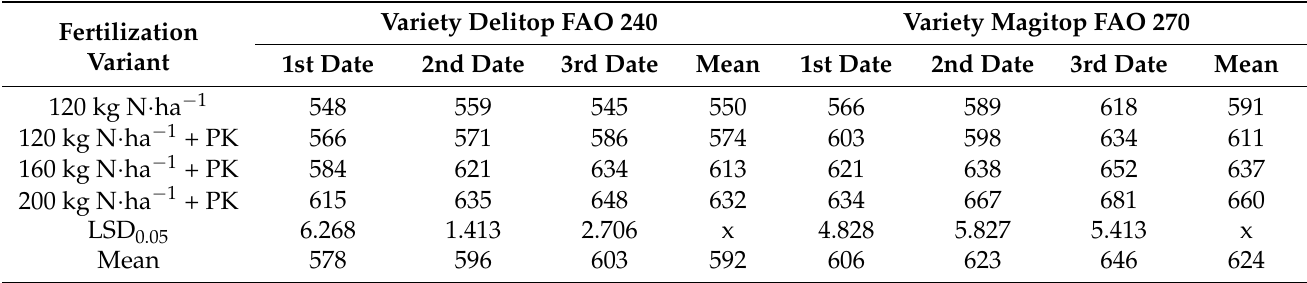
Table 2. The leaf greenness index (SPAD) of two maize varieties depending on the fertilization variant in the first year. Fertilization